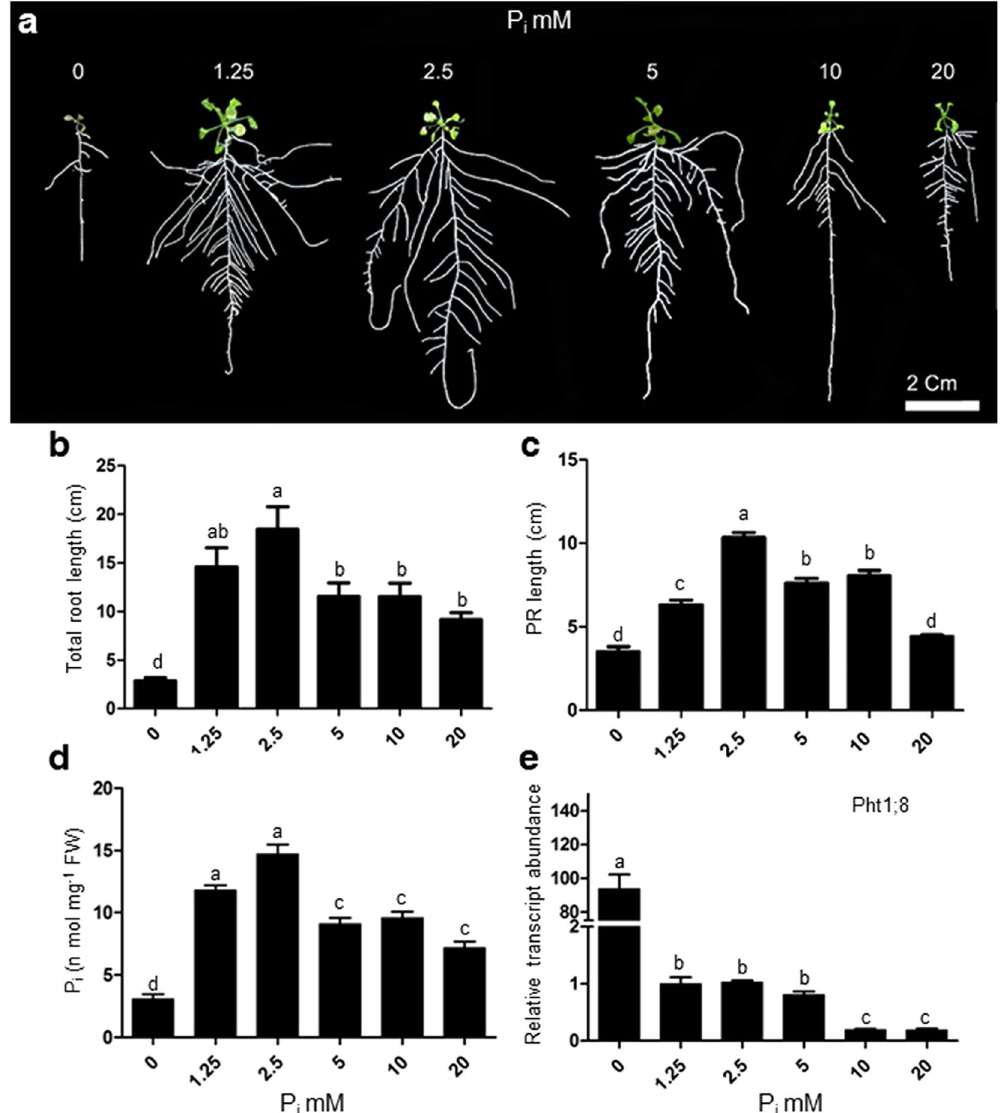
Figure 2. Supply of different concentrations of excess phosphate (P i ) modulates different morphophysiological parameters of root. WT seedlings were grown as described in the caption to Fig. 1. Data are presented for Total root length ( b ), Primary root length ( c ), total soluble P i content ( d ), Expression level of Pht1;8 ( e ), Values are means ± SE, and n = 21 ( b,c ) or n = 3 consists of 20–50 mg root tissue in each assay ( d ). n = 3 consists of 50 mg root tissue for each replicate ( e ). Mean Bars with different alpha letter differ significantly (P ≤ 0.05) according to analysis of variance (1X-ANOVA) with Tukey’s Multiple Comparison